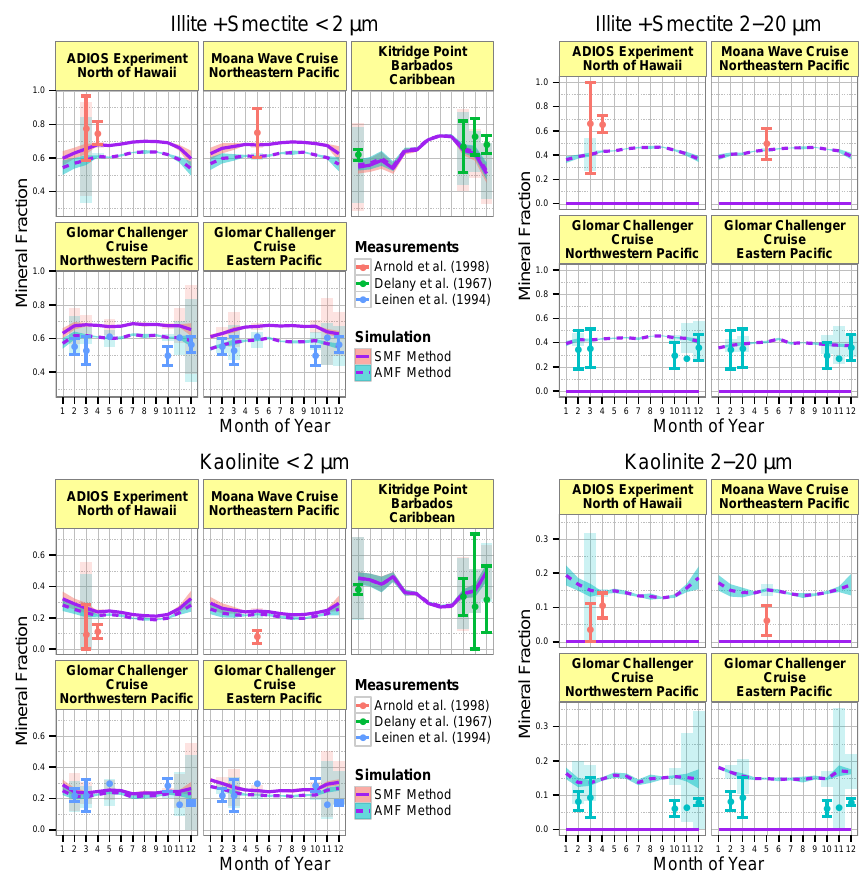
Figure 2. Annual cycle of illite plus smectite and kaolinite fractions for diameters less than 2µm and from 2 to 20µm as measured and simulated by the SMF and AMF methods. The vertical error bars, shaded ribbons, and shaded bars represent the 95% confidence intervals of the measurements, the simulations (based on monthly SDs), and the simulations sampled at the frequency of the measurements,